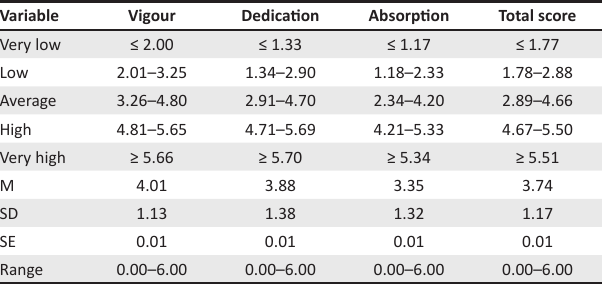
TABLE 3: Utrecht Work Engagement Scale norm